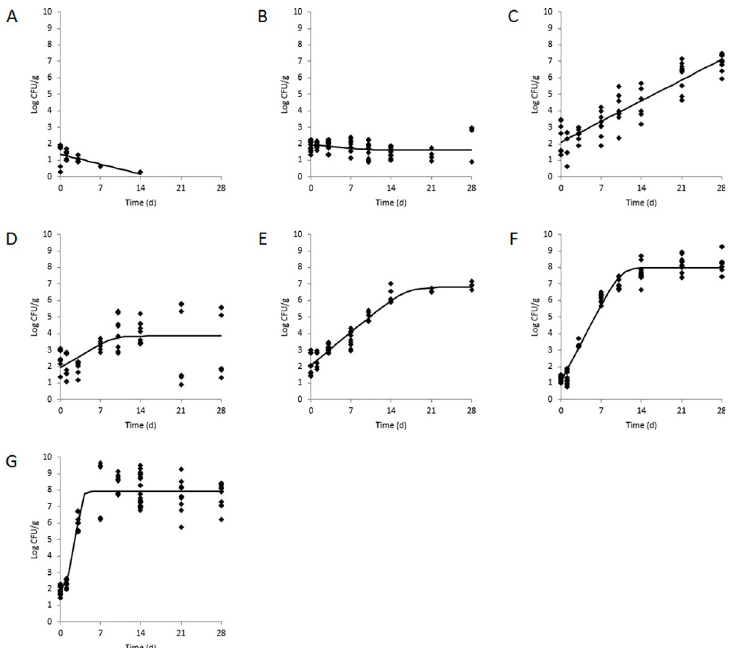
Fig 2. Population dynamics of L . monocytogenes in dip components including A) chopped garlic, B) mashed eggplant, C) chopped basil, D) chopped cilantro, E) chopped jalape ñ o pepper, F) mashed avocado, and G) mashed chickpeas during 28 d storage at 10˚C. Observed data (black circles) with standard deviations (n = 9) and predicted growth models (solid black lines) are shown.